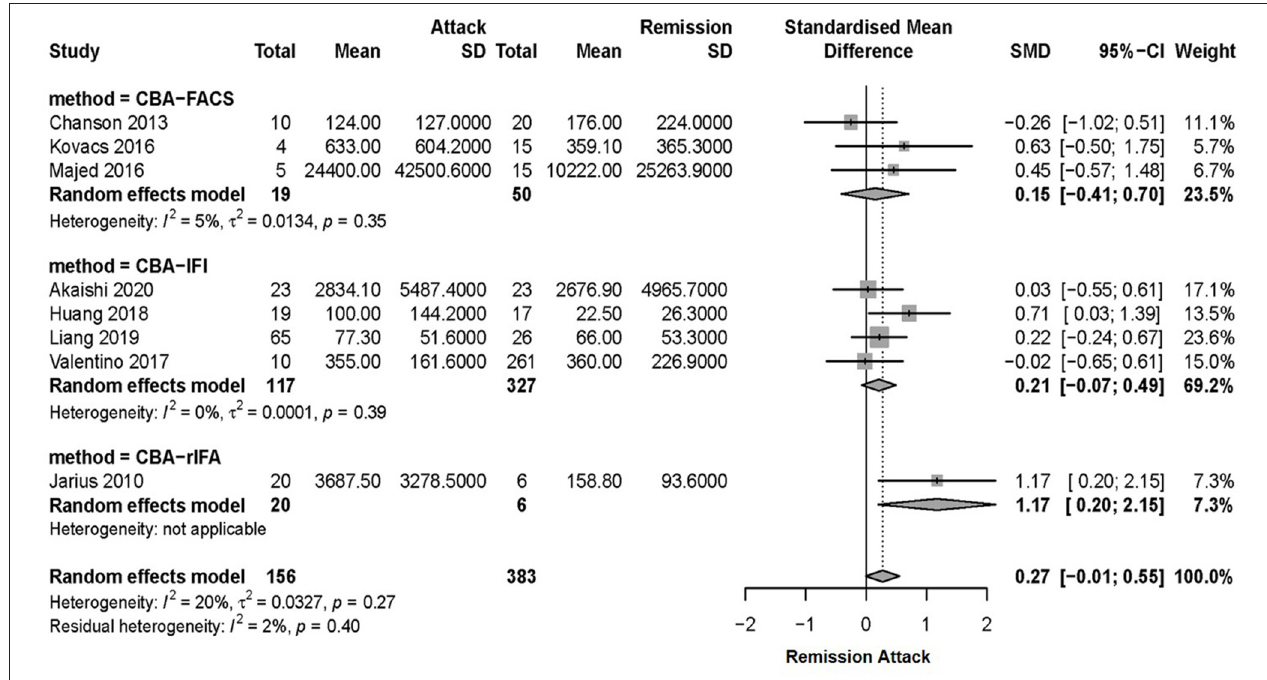
FIGURE 3 | Subgroup meta-analysis of serum AQP4-IgG titer tested by CBA between the attack and remission phase for patients with NMOSD. AQP4-IgG, aquaporin4-IgG; CBA, cell-based assay; FACS, fluorescence-activated cell sorting; IFI, indirect immunofluorescence; NMOSD, neuromyelitis optica spectrum disorder; SD, standard deviation; rIFA, recombinant immunofluorescence assay; 95% CI, 95% confidence interval.